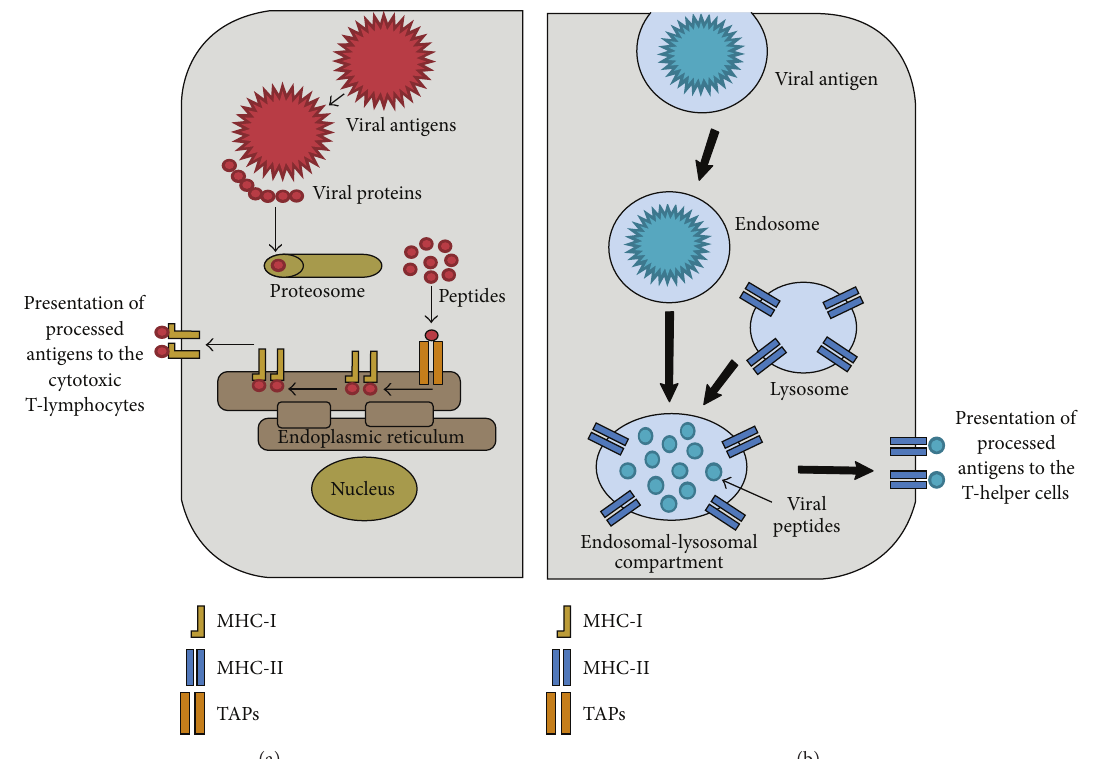
Figure 1: The endogenous and exogenous pathways of viral antigen entry into host cells. (a) Endogenous pathway shows viral antigens that enter the host cells by the intracellular route. Once internalized, the viral antigens are degraded into peptides by proteasomes. Thereafter, the processed antigenic peptides are transported via the transporter associated with antigen presentation (TAPs) to the endoplasmic reticulum (ER) where they are loaded onto MHC-I molecules for presentation at the cell surface to CD8+ T-cells. (b) Exogenous pathway shows antigens that enter the antigen presenting cells (APCs) via the extracellular route which results in internalization of the antigens in the endosomes. Thereafter, the endosomes fuse with the lysosomes to form the endosomal-lysosomal compartments that have MHC-II complexes. In the endosomal-lysosomal compartments, the antigens are degraded into peptides followed by packaging of the peptides onto MHC-II complexes. Thereafter, the MHC-II complexes carrying the peptides are transported to the cell surface for presentation of the antigenic peptides to the CD4